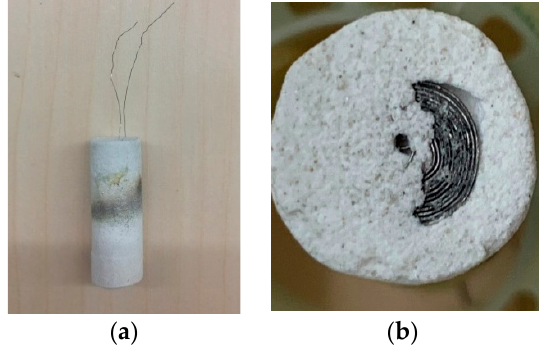
Figure 6. ( a ) Encapsulated sensor; ( b ) Sensor Coil in the encapsulation.